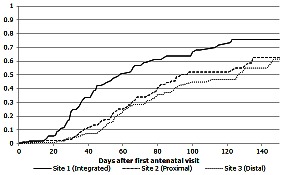
Kaplan-Meier failure estimates of time to treatment in women who initiated ART in pregnancy.